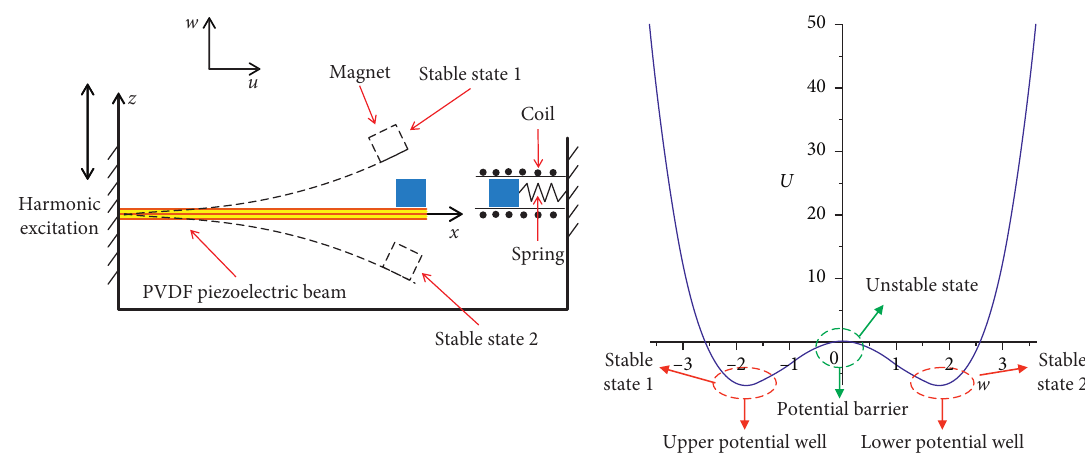
Figure 3: Model of the generator.